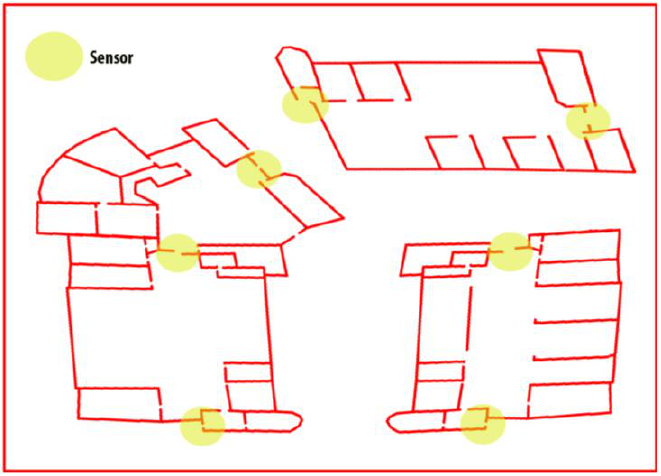
Figure 2. An installation map for three buildings. The locations of network sensors are shown in yellow. The sensors are placed in strategic positions, one per building exit, in an attempt to use a minimal number of